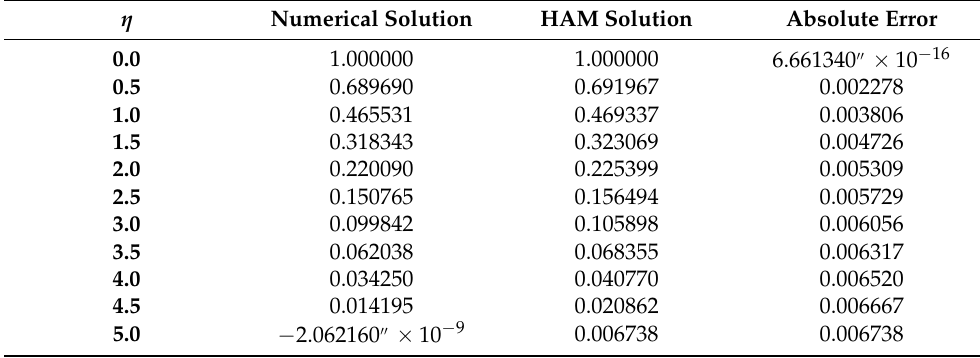
Table 3. Numerical solution via analytical solution for concentration of nanoparticle